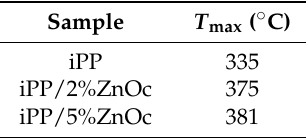
Figure 8. Thermostability curve of iPP and iPP/ZnOc composites. Table 2. Thermal degradation temperature at which the degradation rate is maximum ( T max ).